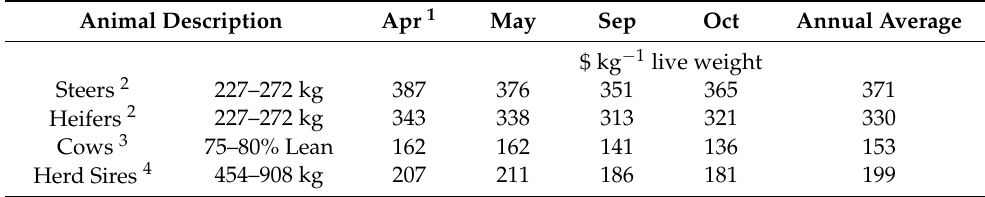
Table 4. 2011–2020 average monthly cattle prices by cattle type, weight, and month,